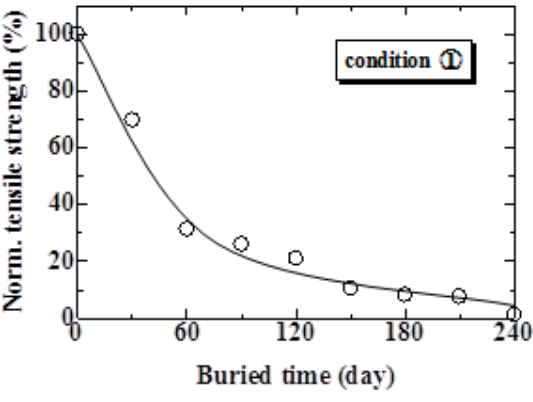
Figure 6. Relationship between normalized tensile strength and burial period under Condition 1.